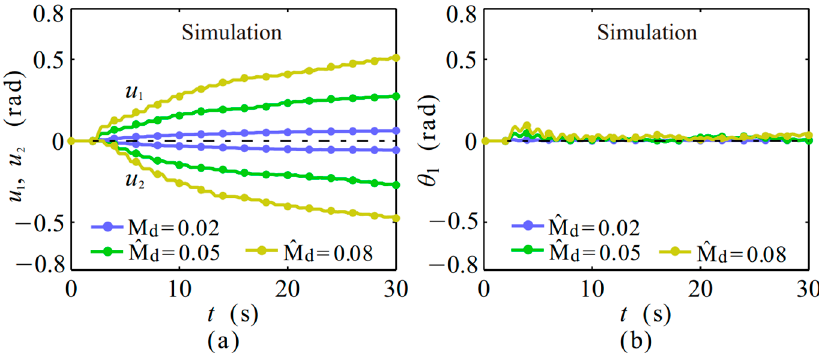
Figure 12. Serial-stiffness-switch system simulation results for harmonic disturbances under different